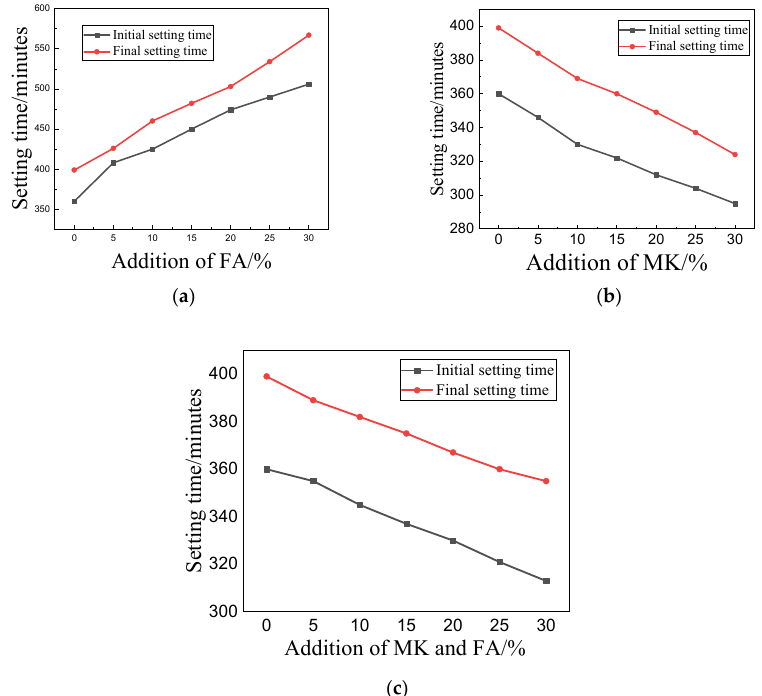
Figure 3. Setting times of MOSC composite pastes: ( a ) C-FA; ( b ) C-MK; ( c ) C-(MK+FA).